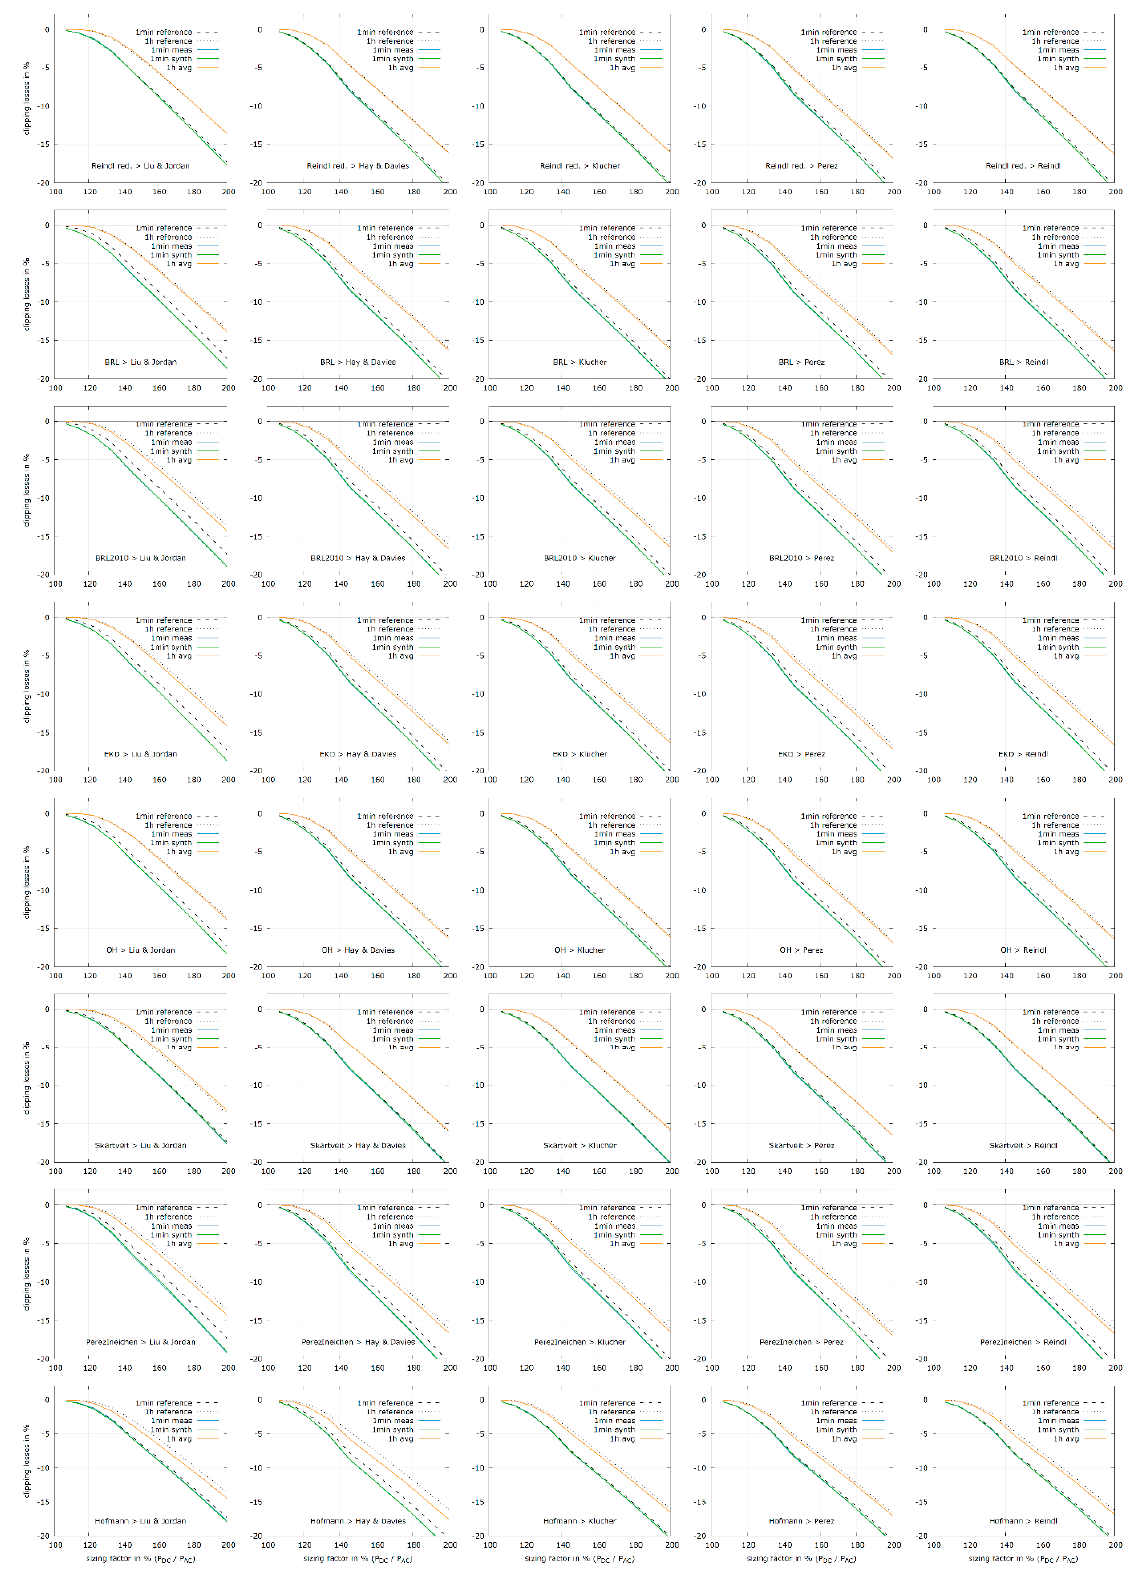
Figure A6. Same plot as Figure A5, but for inverter with an ideal efficiency of 100% over the whole operating range.